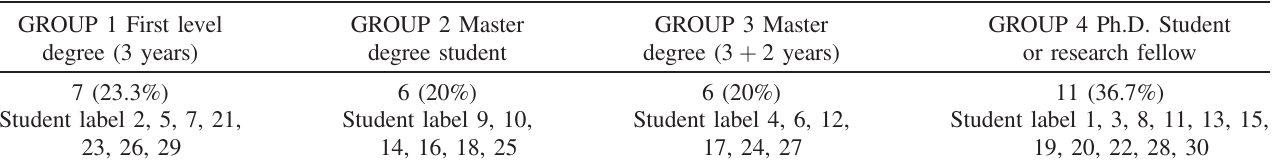
TABLE II. Number of students having specific characteristics of instruction in this